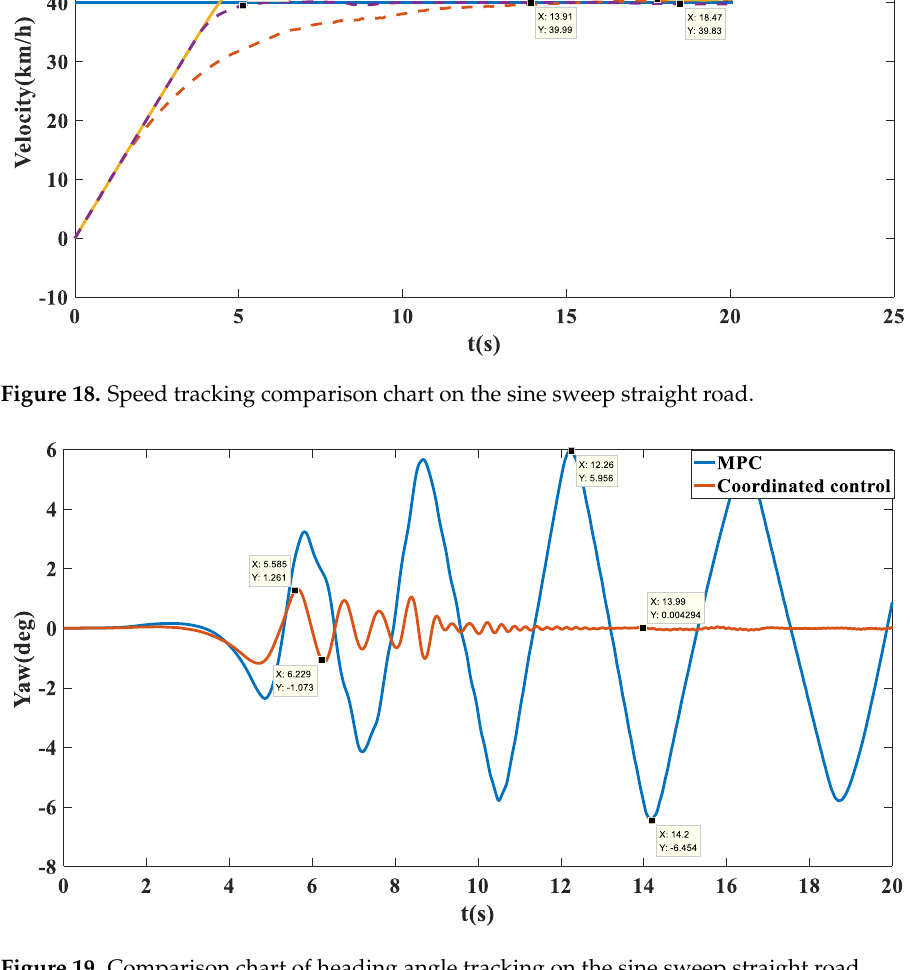
Figure 19. Comparison chart of heading angle tracking on the sine sweep straight road.